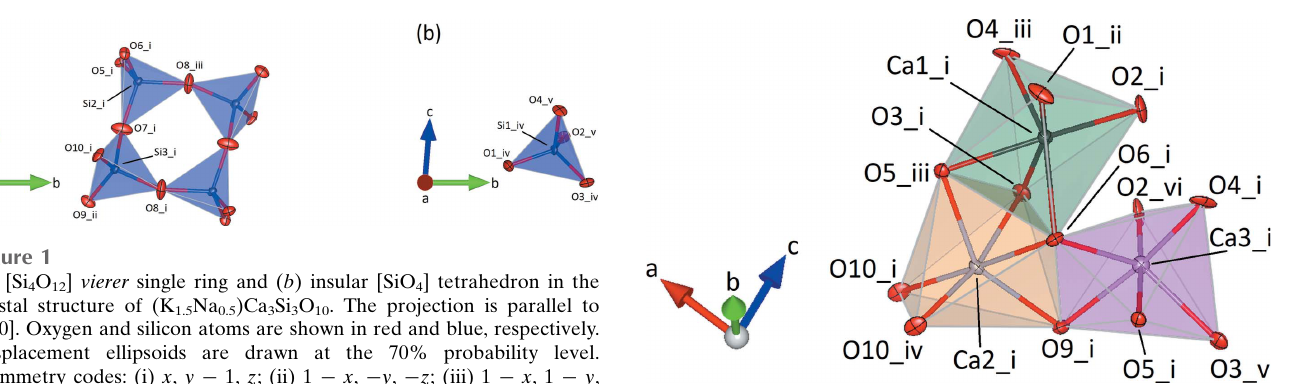
Figure 3 Cluster of three octahedra around Ca1 (green), Ca2 (orange) and Ca3 (pink). Oxygen and calcium atoms are shown in red and gray, respectively. Displacement ellipsoids are drawn at the 70% probability level. [Symmetry codes: (i) x , y , z ; (ii) x , y + 1, z ; (iii) 1 + x , y , z ; (iv) 2 (cid:3) x , 1 (cid:3) y , - z; (v) (cid:3) 1 + x , y , z ; (vi) 1 (cid:3) x ,1 (cid:3) y ,1 (cid:3) z .]